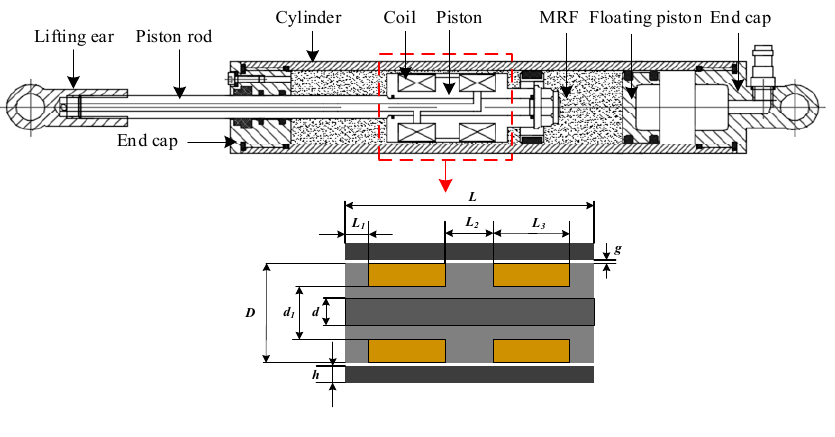
Figure 1. A typical device of MRD.